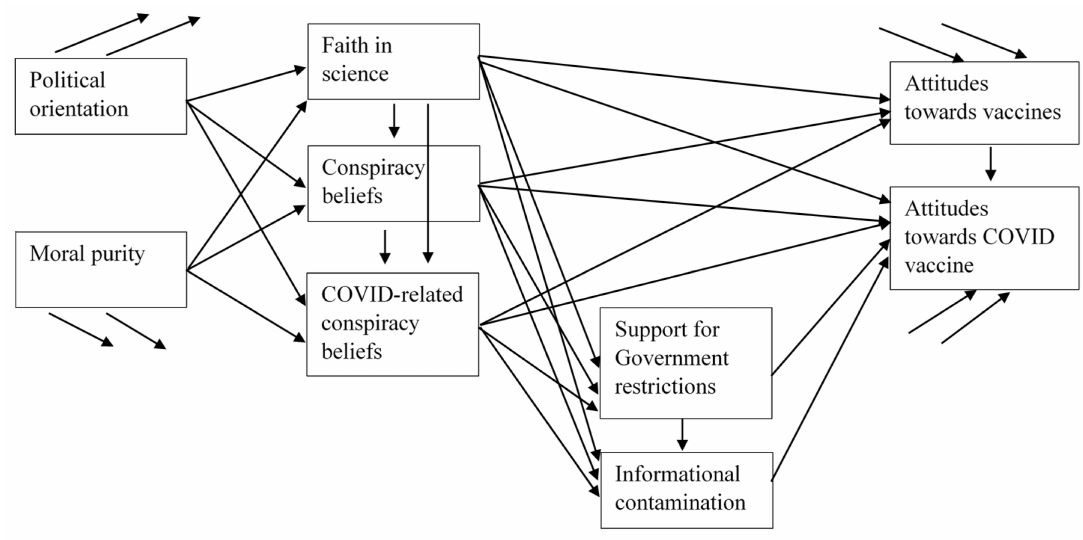
Figure 1. Hypothesized Model